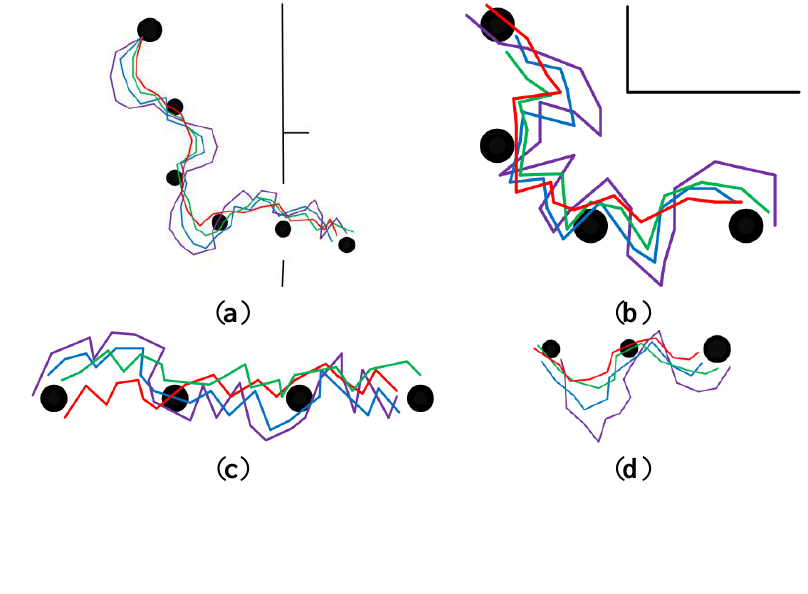
Figure 10. The homing trajectories in modified environments with fairly good illumination. ( a – d ) show the results obtained in phase 1, 2, 3 and 4, respectively. Red lines correspond to the proposal. Violet lines correspond to SURF. Blue lines correspond to the proposal without selection and updating. Green lines correspond to the proposal without updating. In each figure, the robot moves from left to right, the black disks with the same size are intermediate nodes, and the bigger one is starting node or home